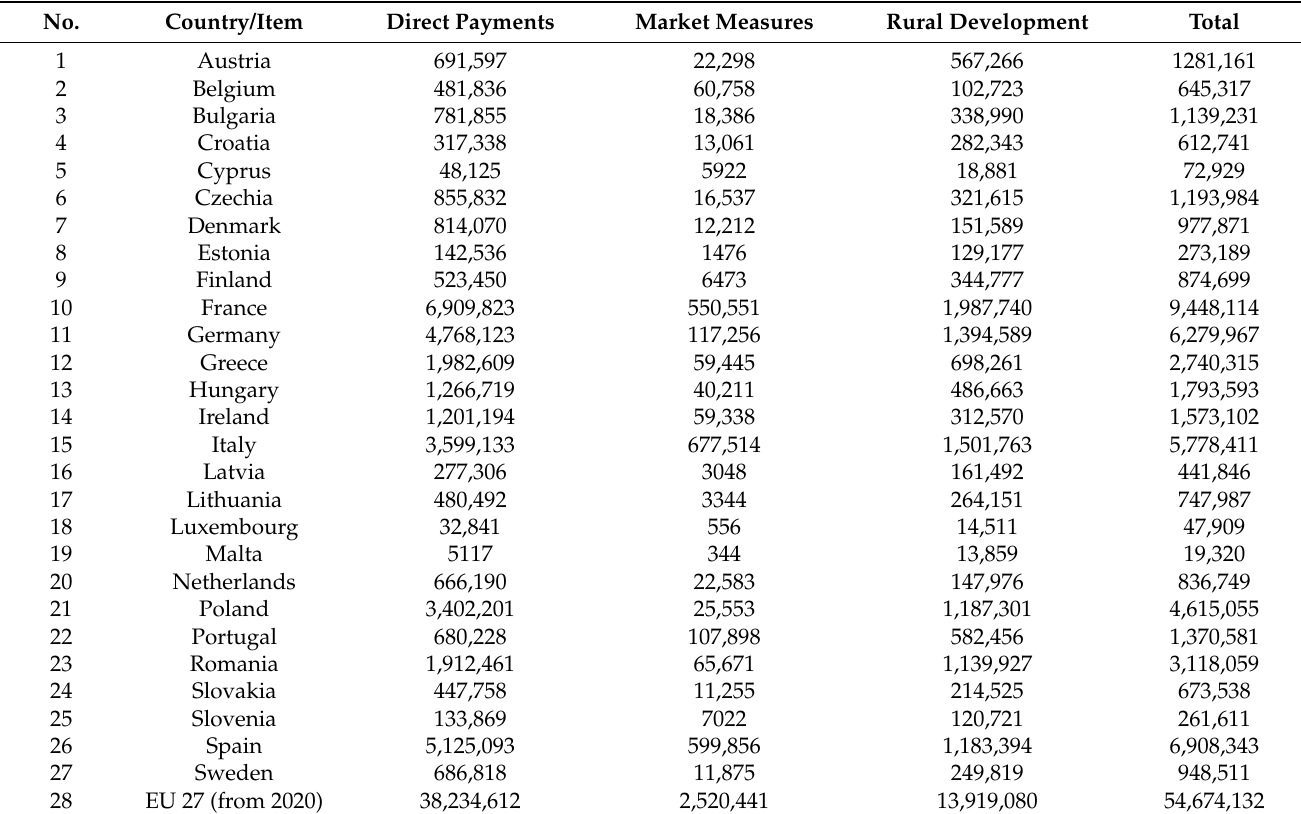
Table 5. CAP expenditure by Member State in 2020, thousand euro.